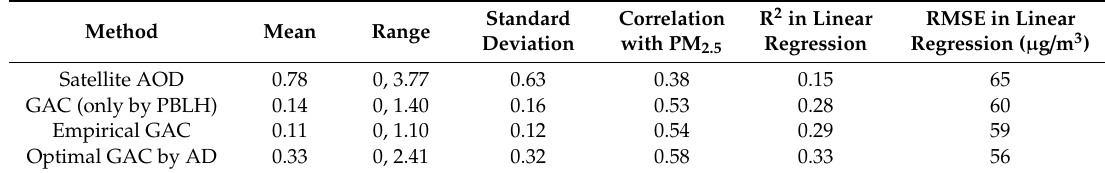
Table 3. Metrics of AOD and GACs simulated by di ff erent methods in the test.